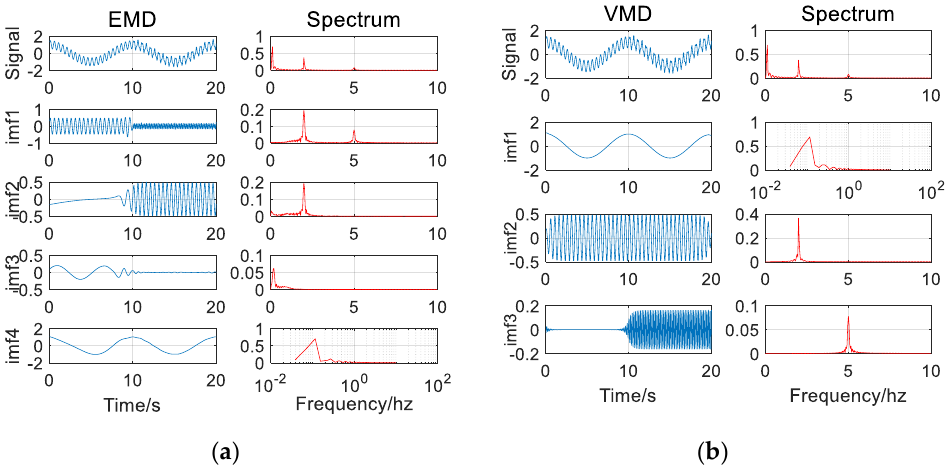
Figure 8. ( a ) The EMD decomposition results of the signal (with discontinuous signal); ( b ) The VMD Figure 8. (a) The EMD decomposition results of the signal (with discontinuous signal); (b) The VMD decomposition results of the signal (with discontinuous signal). decomposition results of the signal (with discontinuous signal).